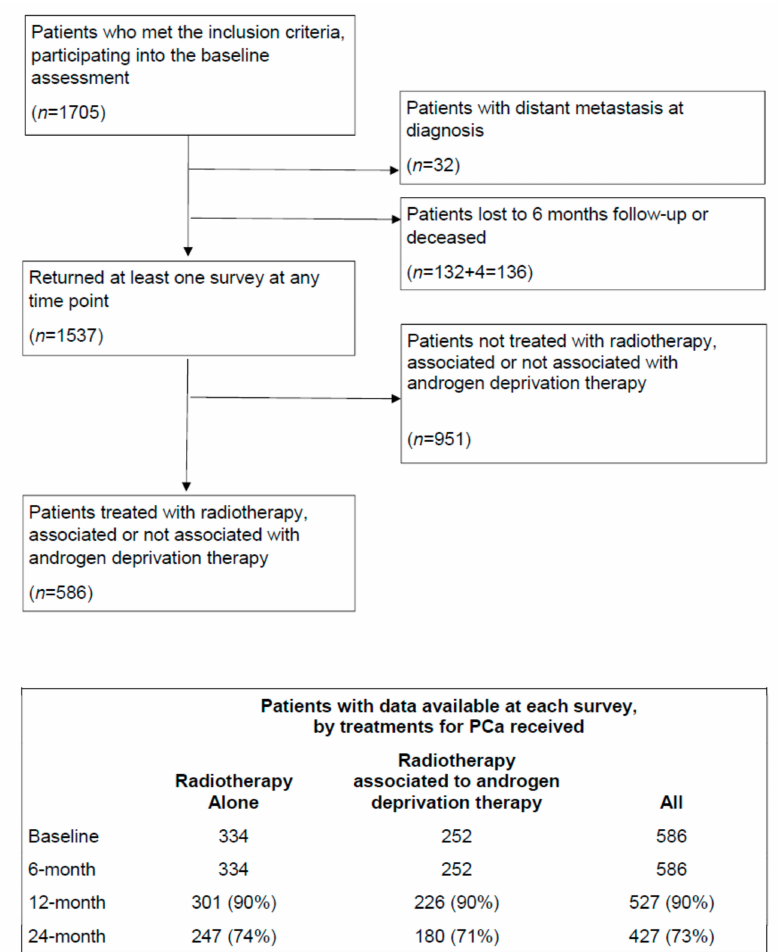
Figure 1. Flow diagram of the analytic cohort considered in the present analysis. With the exception of the number of comorbidities, the three groups of patients showed non-significant unadjusted differences in characteristics at diagnosis (Table 1). The difference between trajectory 2 and 3 at presentation (Figure 2b), may be due to the different spectra of comorbidities before PCa treatments; data after treatment, however, are almost overlapping. In comparison to patients following trajectories 2 and 3, those on trajectory 1 have worse BF at presentation, and even worse BF at the six-month follow-up, probably due to acute RT toxicity in patients submitted to less sophisticated treatments, then only partially